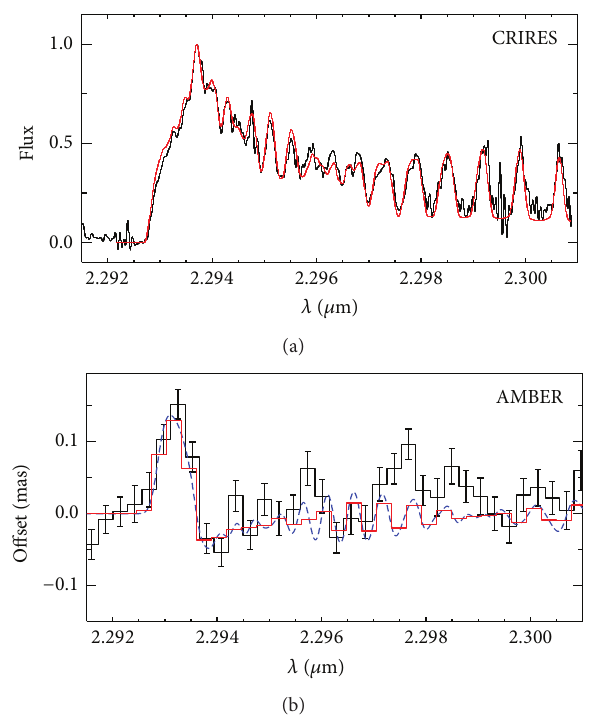
Figure 2: VLTI/AMBER and VLT/CRIRES observations of CO bandhead emission of HD 327083 [61]. (a): Observed flux spec- trum (black) and model fit (red) based on a Keplerian disk. (b): Differential phase spectrum (histogram) with the Keplerian model prediction at a spectral resolution of VLT/CRIRES (blue) and of VLTI/AMBER (red). Reproduced with permission from Astronomy & Astrophysics, ©